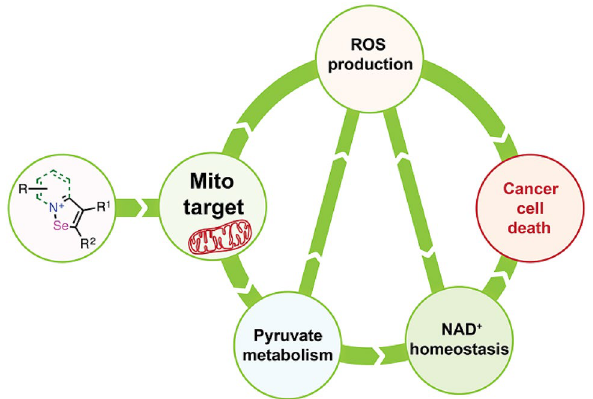
Figure 6. Proposed cytotoxicity-inducing mechanism of action of isoselenazolium